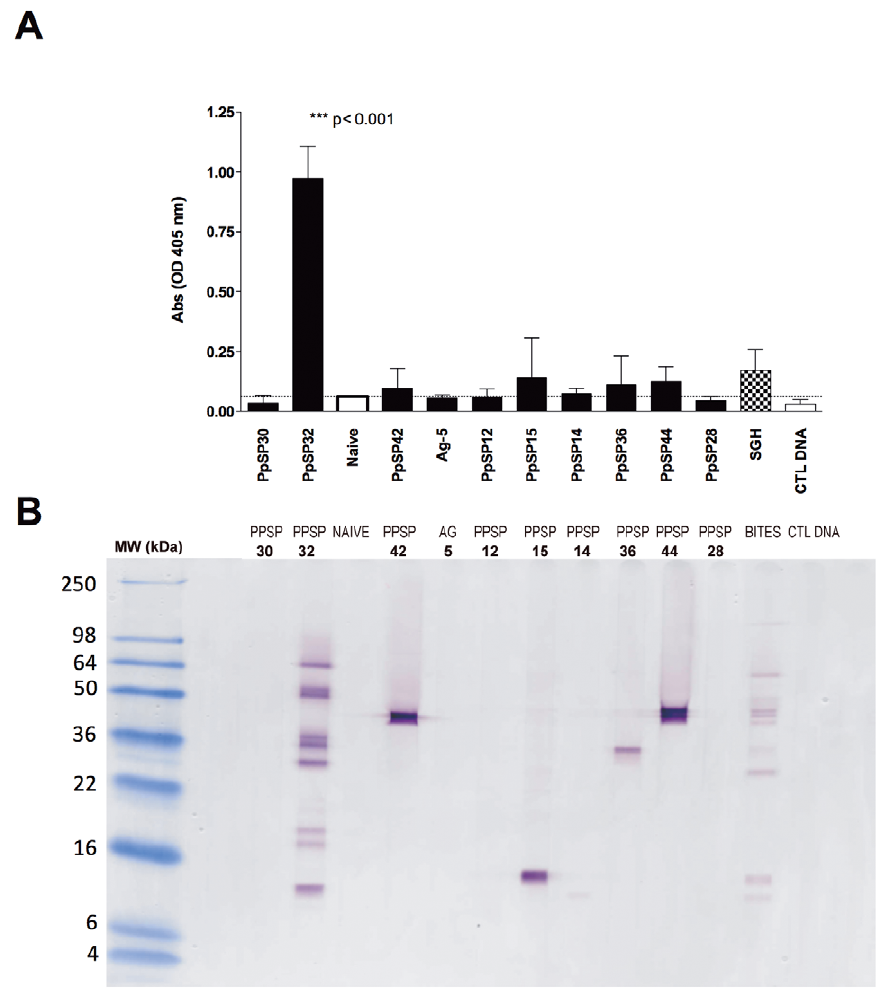
Figure 9. ELISA and Western blot of sera of mice vaccinated with DNA plasmids. ( A ) C57BL/6 mice were immunized three times at two weeks interval with their DNA plasmids coding for the most abundant P. papatasi salivary proteins and sera obtained 2 weeks after last immunization. Total anti-saliva IgG was measured by ELISA. Five mice were used in each group. Data are representative of three independent experiments. Bars represent mean 6 SD. ( B ) Western blot showing recognition of P. papatasi salivary proteins by sera of mice injected with different DNA plasmid coding for P. papatasi salivary proteins. Mice sera of each group of plasmids were pooled before testing.